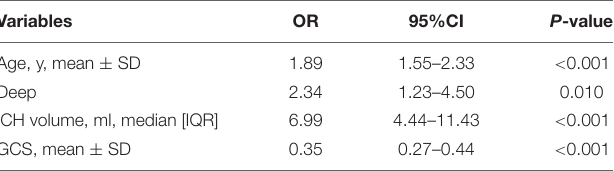
TABLE 3 | Multivariate analysis for poor outcome in the training cohort.